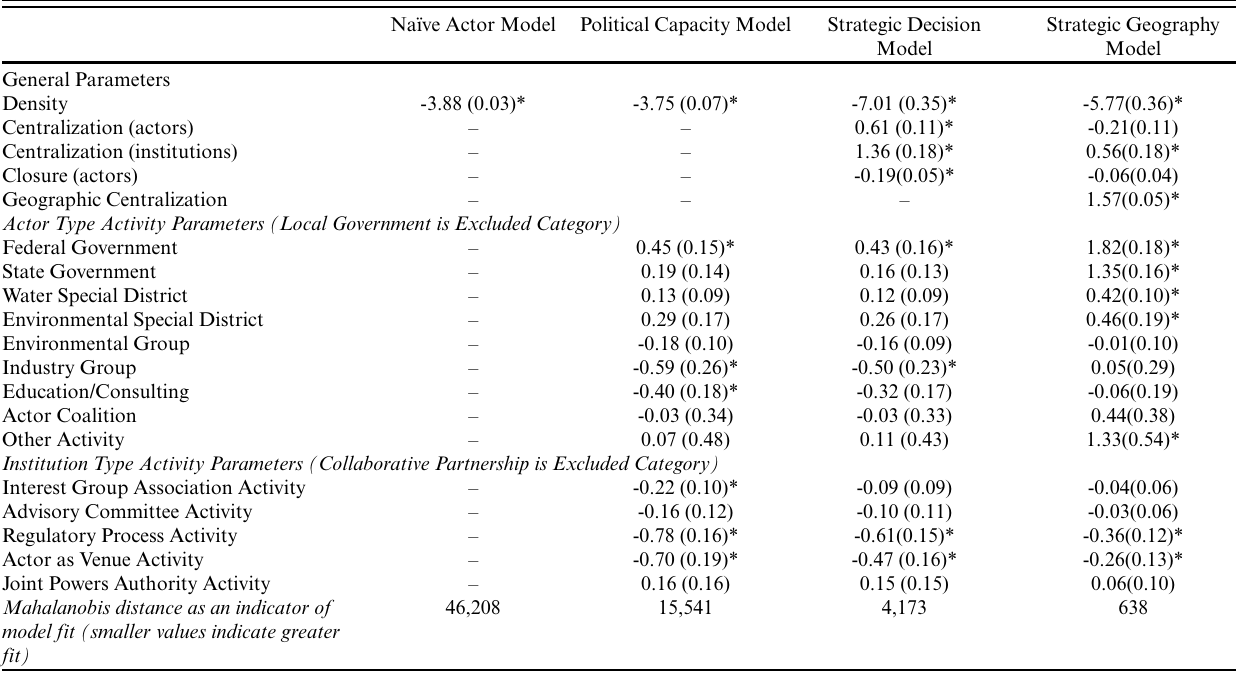
Table 2 . Exponential random graph model (ERGM) parameter estimates